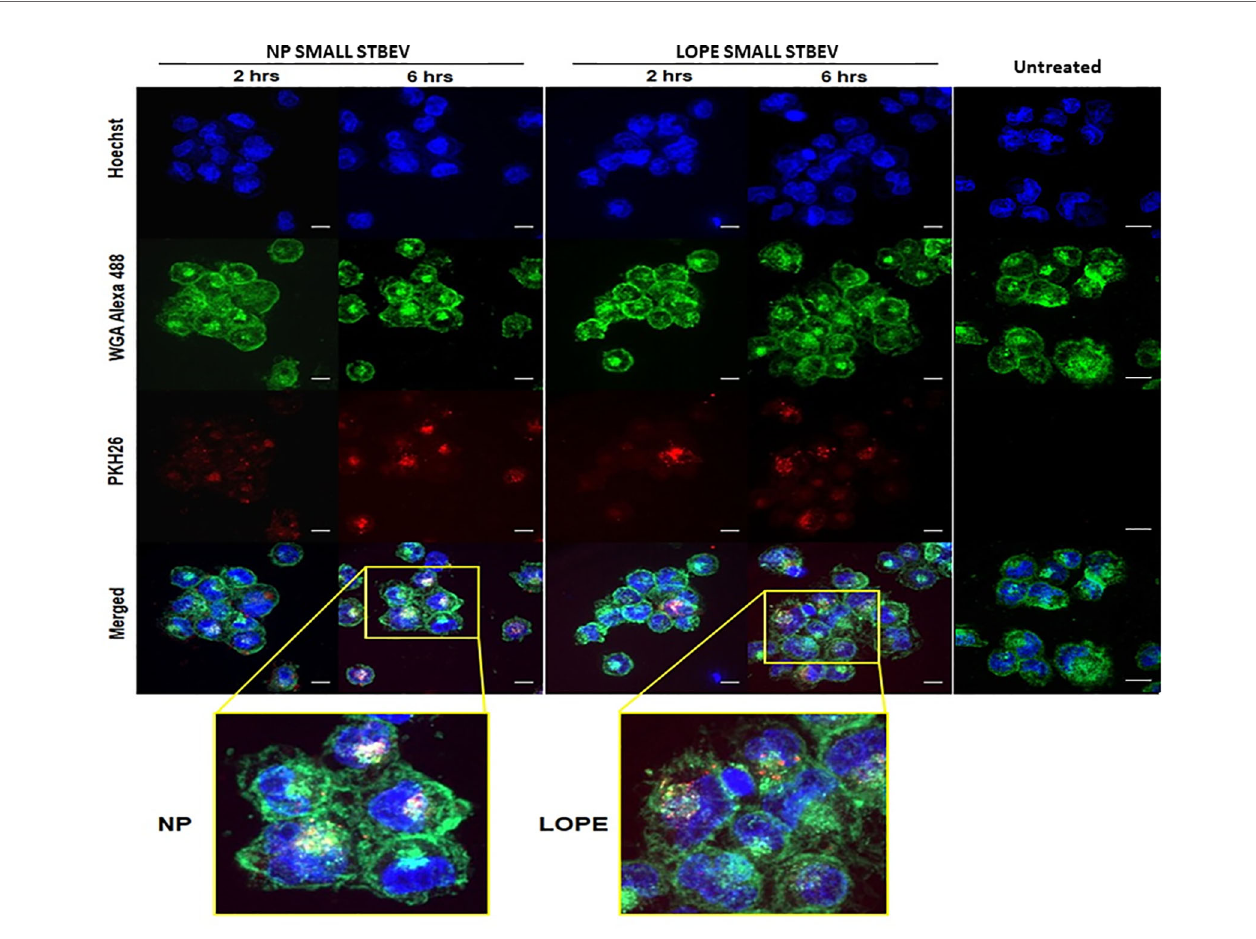
FIGURE 5 | The internalisation of small STBEVs from NP and PE placentae into THP-1 cells by confocal microscopy (technical replicate =3). Small STBEVs derived from NP and PE patients incubated for 2 and 6 hours incubation with differentiated THP-1 cells. Channels panel show cells ’ nuclei labelled with Hoechst dye (blue), cells ’ membrane labelled with WGA Alexa 488 (green), STBEVs labelled with PKH26 dye (red) and merged channels. THP-1 only incubated with no STBEVs (from Figure 4 ) was used as the control. Scale bars, 10 m